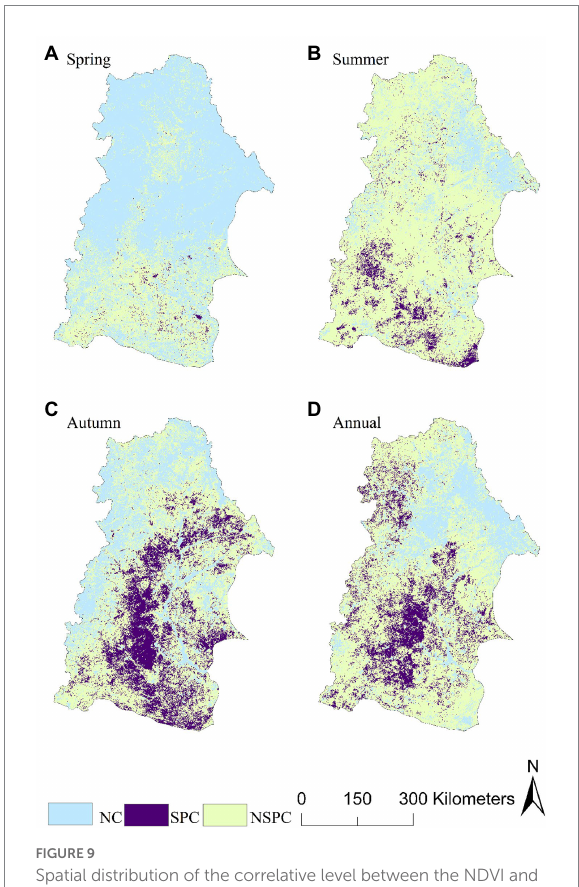
FIGURE 9 Spatial distribution of the correlative level between the NDVI and SPEI lagged period effect at the seasonal and annual scales.